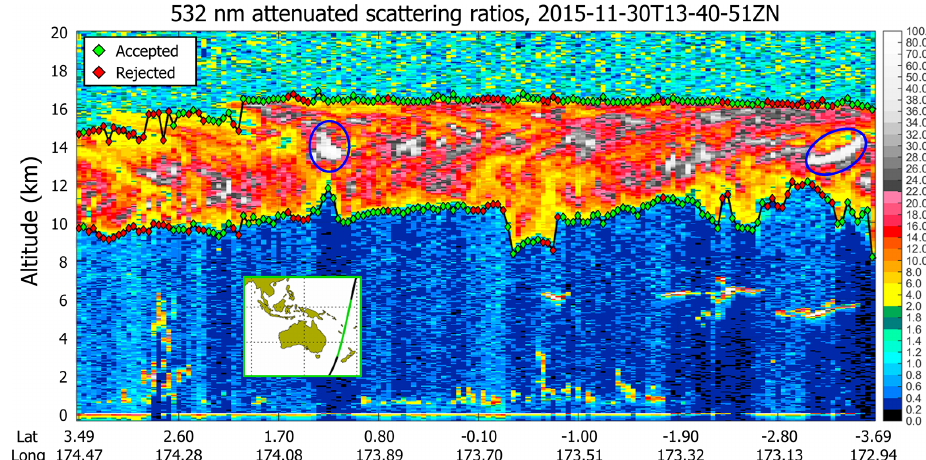
Figure 12. 532nm attenuated scattering ratios, averaged to 5km horizontally and 60 m vertically, for an extended cirrus layer in the southwest Pacific near New Caledonia on 30 November 2015. Potential V3 calibration opportunities ( R (cid:48) white patches lying within the blue ovals. V4 cloud boundaries are indicated by filled diamonds. The boundaries of those clouds for which <0.038sr − 1 are shown in green. The boundaries of clouds having γ (cid:48) 0.023sr − 1 < γ (cid:48) 532